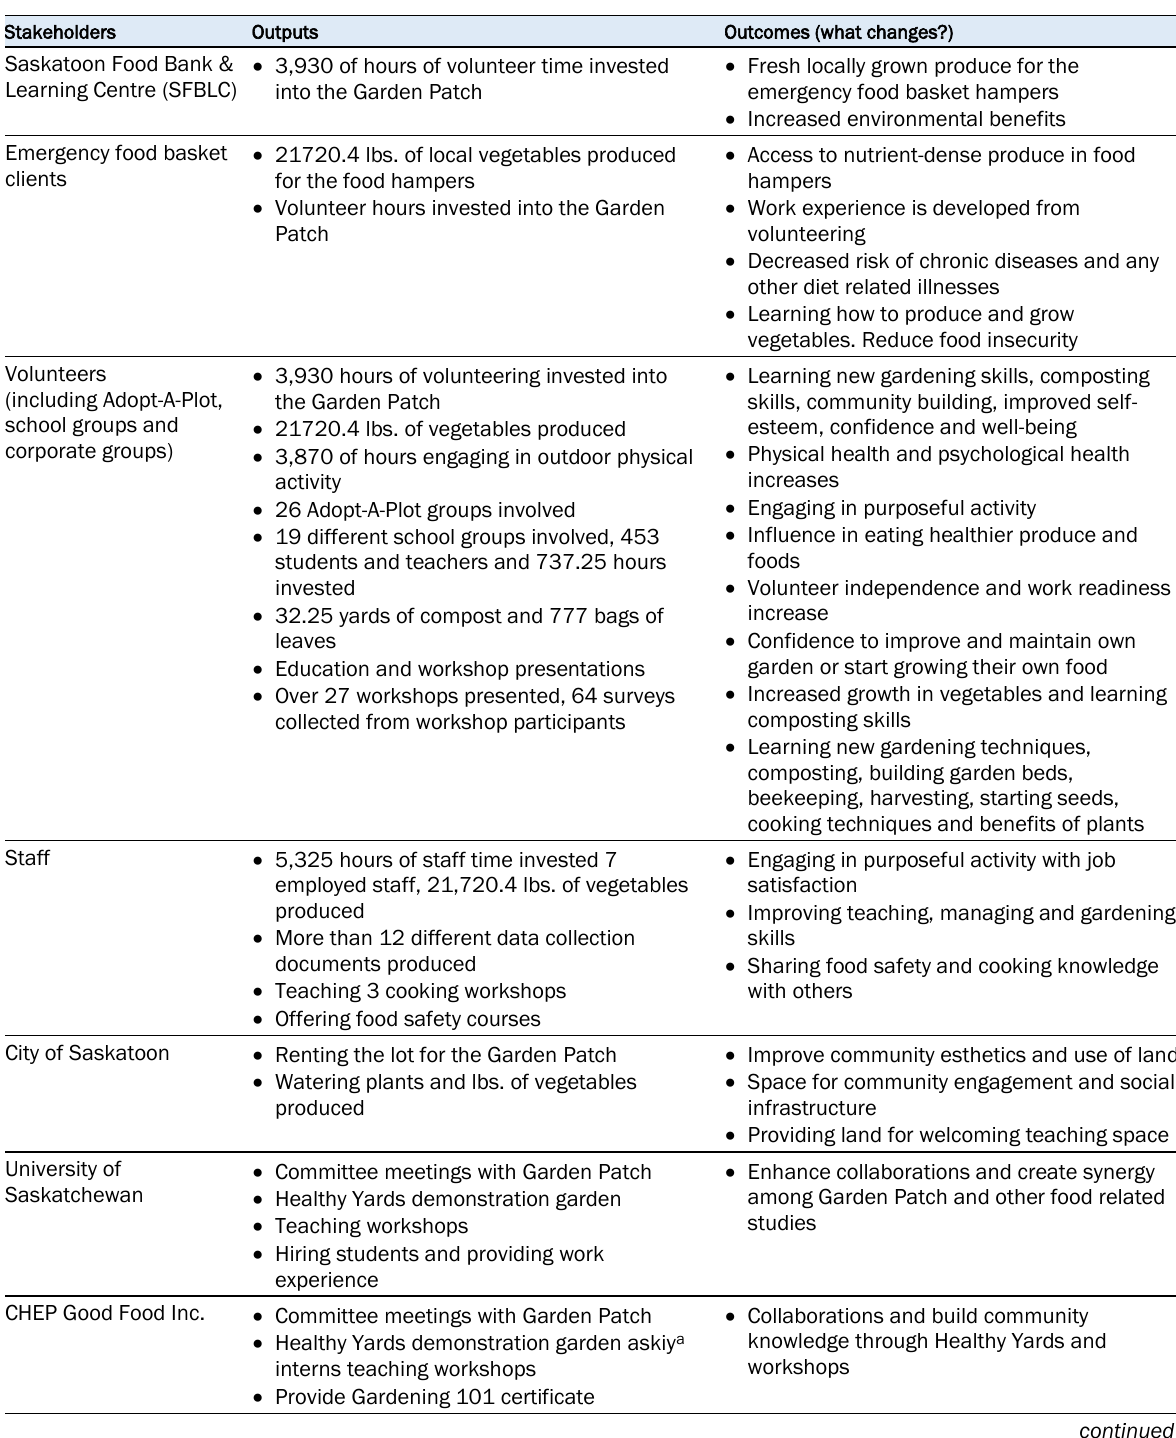
Table A1. Stakeholders, Outputs, and Outcomes of the Garden Patch, 2018